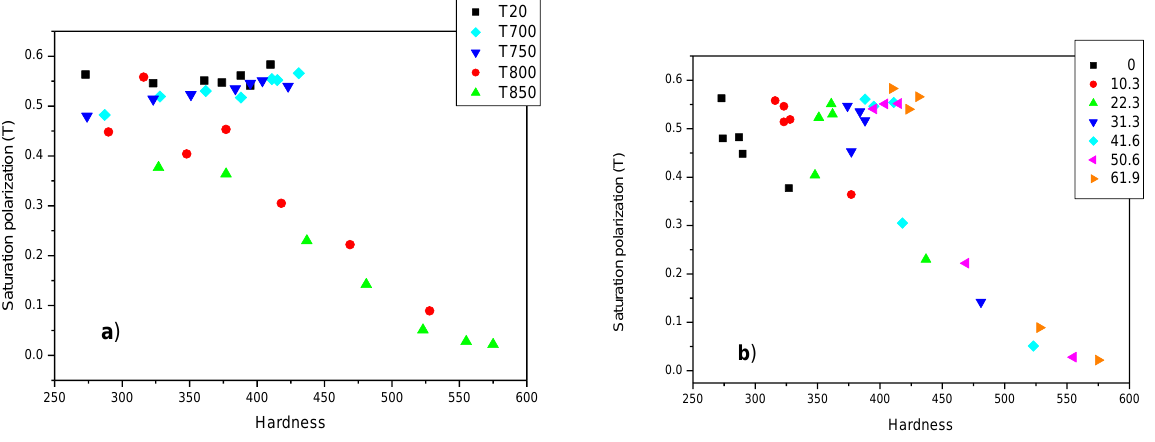
Figure 16. ( h a = 1200 and h b = 1300) m matrix elements for all samples, indicating the actual heat treatments as functions of the hardness.